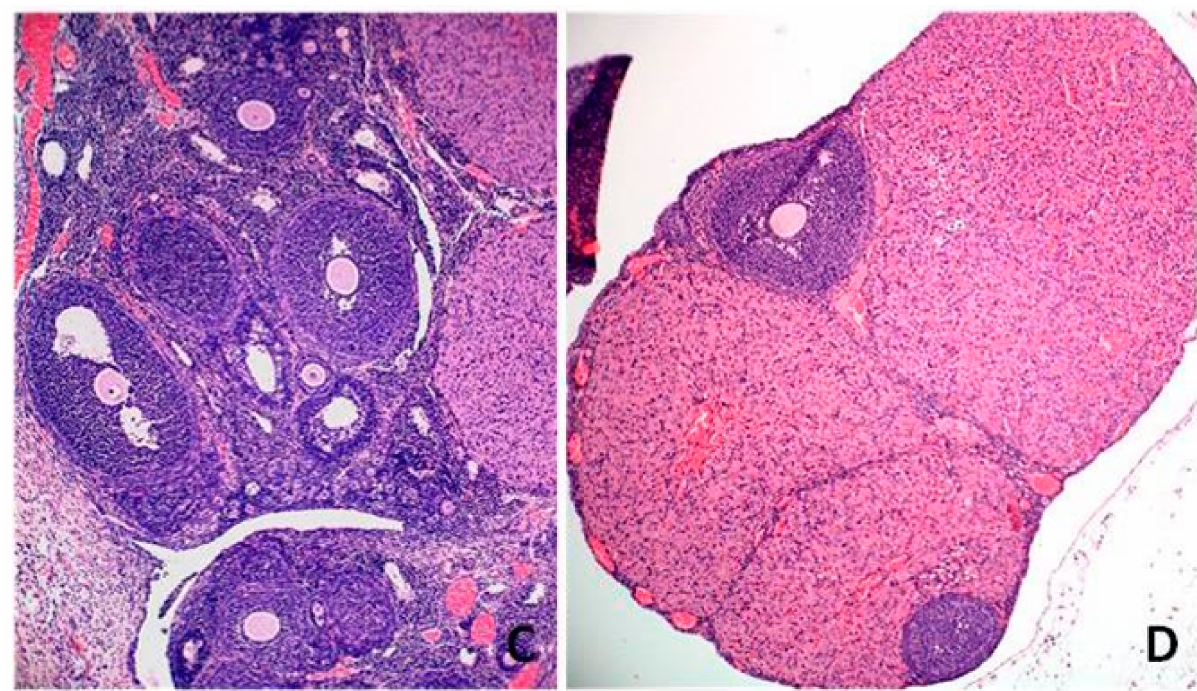
Figure 9. Hematoxylin–eosin-stained cross sections of rat’s ovaries with antral follicles in the control group ( A , C ) and ABA group ( B , D ). The ABA group is characterized by a poor follicle pool; only a few follicles were observed in the marginal part of ovaries. Total magnification: 40 × ( A , B ); 100 × ( C , D